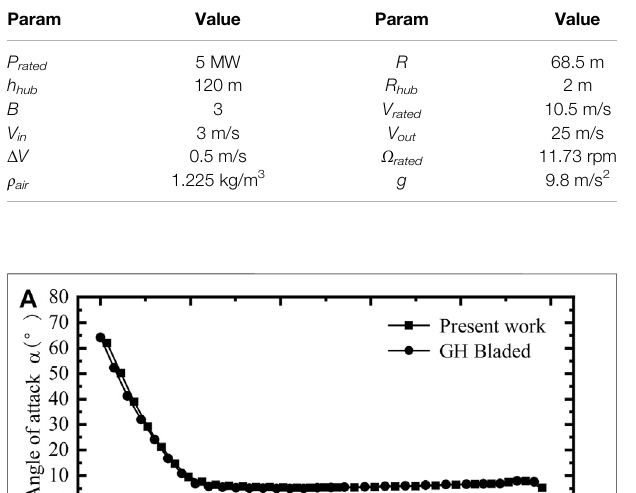
TABLE 1 | The parameters of reference 5-MW downwind wind turbine. Param